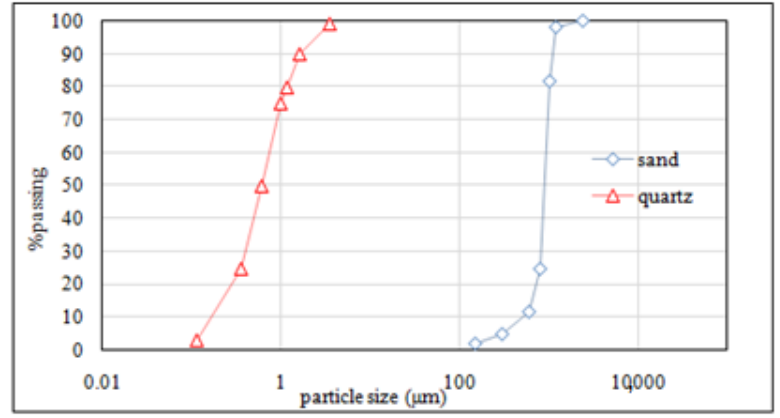
Figure 1. Quartz sand and powder distribution of particles.